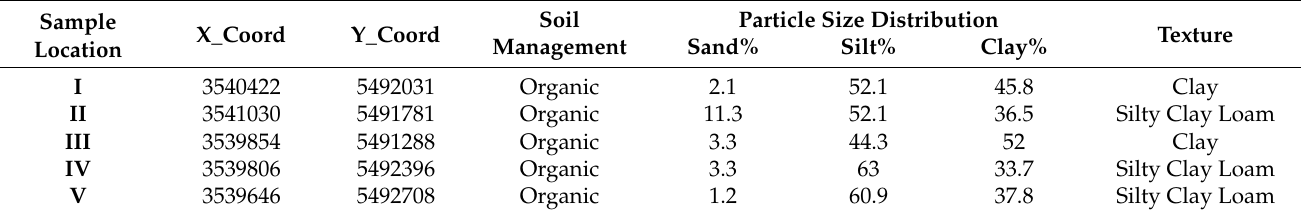
Table 2. Physical properties of the investigated sample locations.